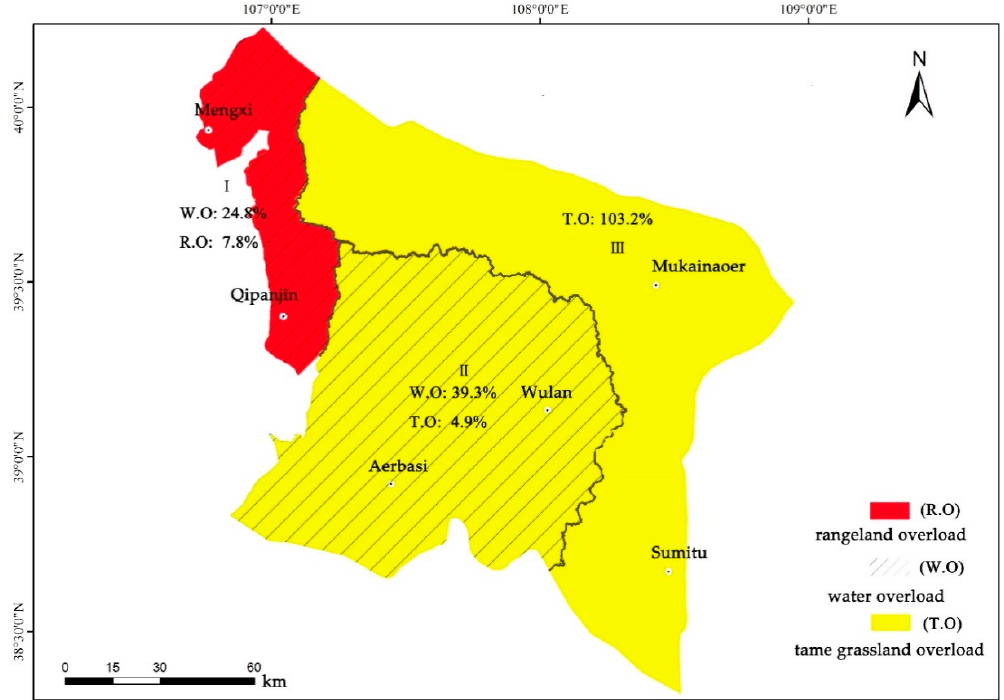
Figure 4. The water and forage resource overload situation based on the dynamic WFLB model in OtogBanner.